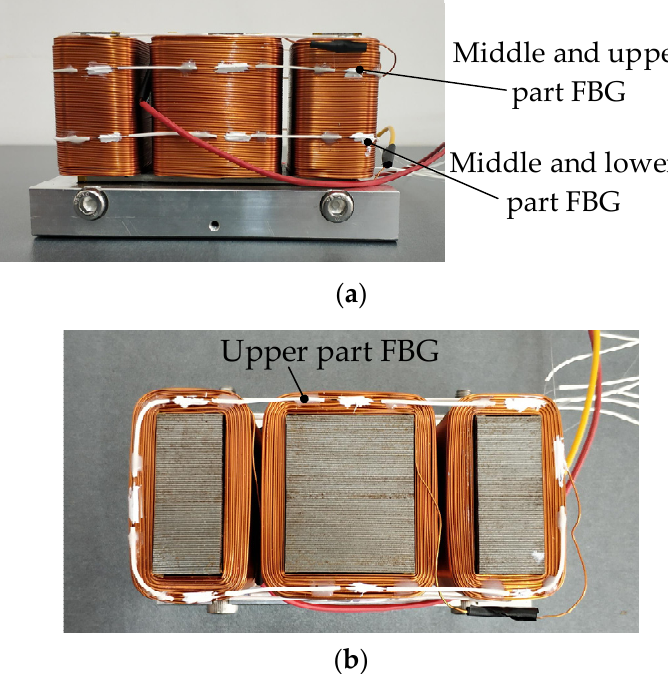
Figure 15. Arrangement of FBG sensor in coil winding. ( a ) Main view; ( b ) vertical view.